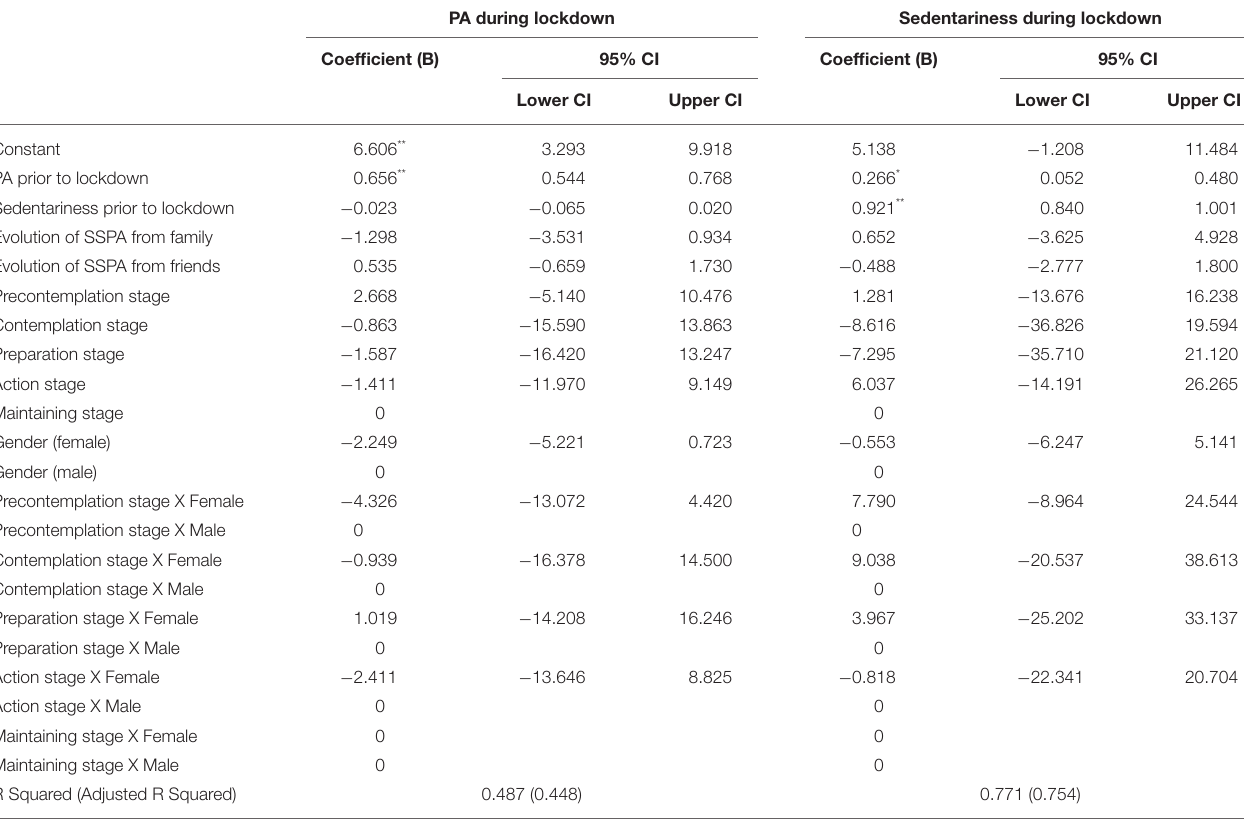
TABLE 8 | General linear model for workers ( n =